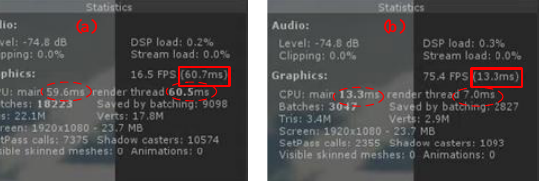
Figure 7. Render statistics after static batch processing. ( a ) BSBP render statics; ( b ) ASAP render parameters.